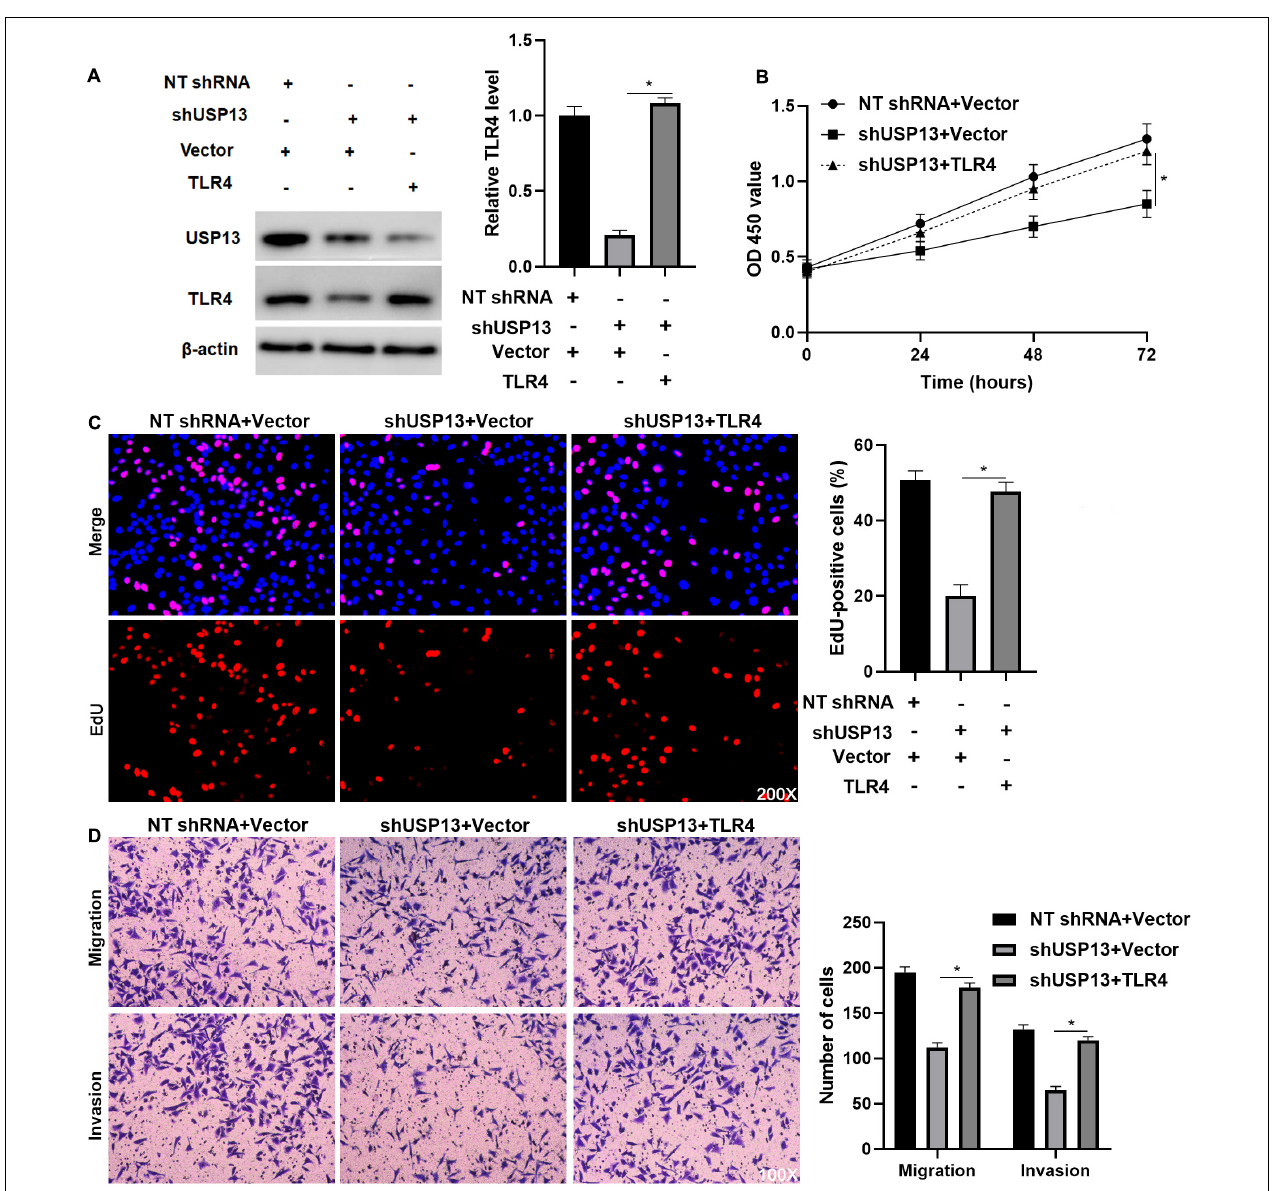
FIGURE 6 | TLR4 re-expression abrogates the effects of USP13 knockdown on Hep3B cells. (A) TLR4 expression was rescued by plasmid transfection in Hep3B cells with USP13 knockdown. (B) CCK-8, (C) EdU, and (D) transwell assays were performed to assess the proliferation, migration, and invasion of Hep3B cells after transfecting with corresponding vectors. * P <